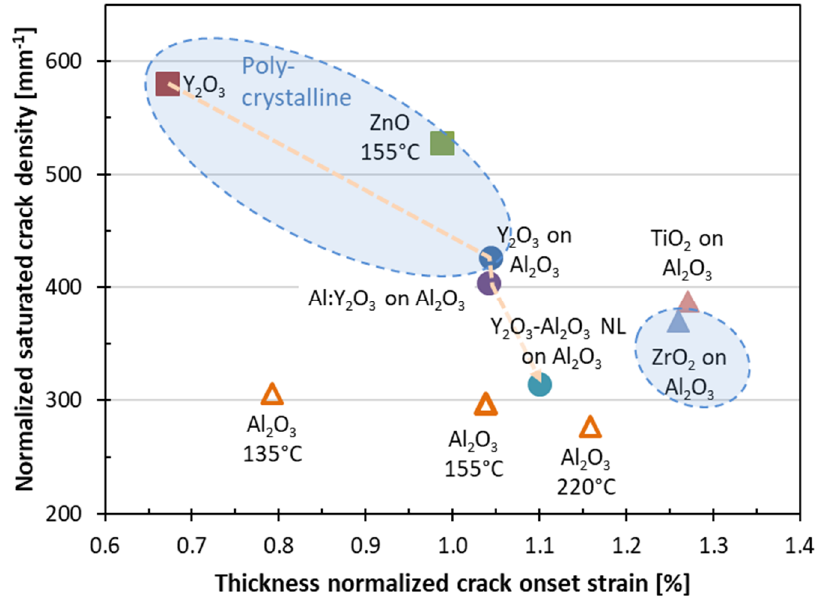
Figure 7. The crack density values vs. crack onset strain values, as normalized to 50 nm thickness. Y 2 O 3 -based films are connected by the yellow dashed line to indicate improvements owing to the interfacial Al 2 O 3 film, Al-doping, and nanolaminating. The blue dashed lines enclose the data for the polycrystalline films. The errors bars (omitted for clarity) are around 10% for the saturated crack density values and 10%–15% for the crack onset strain values.